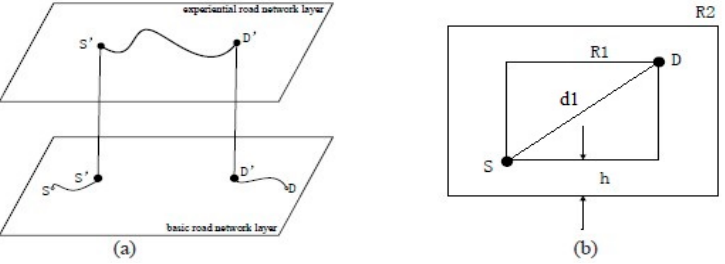
Figure 6. ( a ) Hierarchical Experimental Network ( b ) Definition of the rectangle for the main network Ji-Hua et al. (2013).